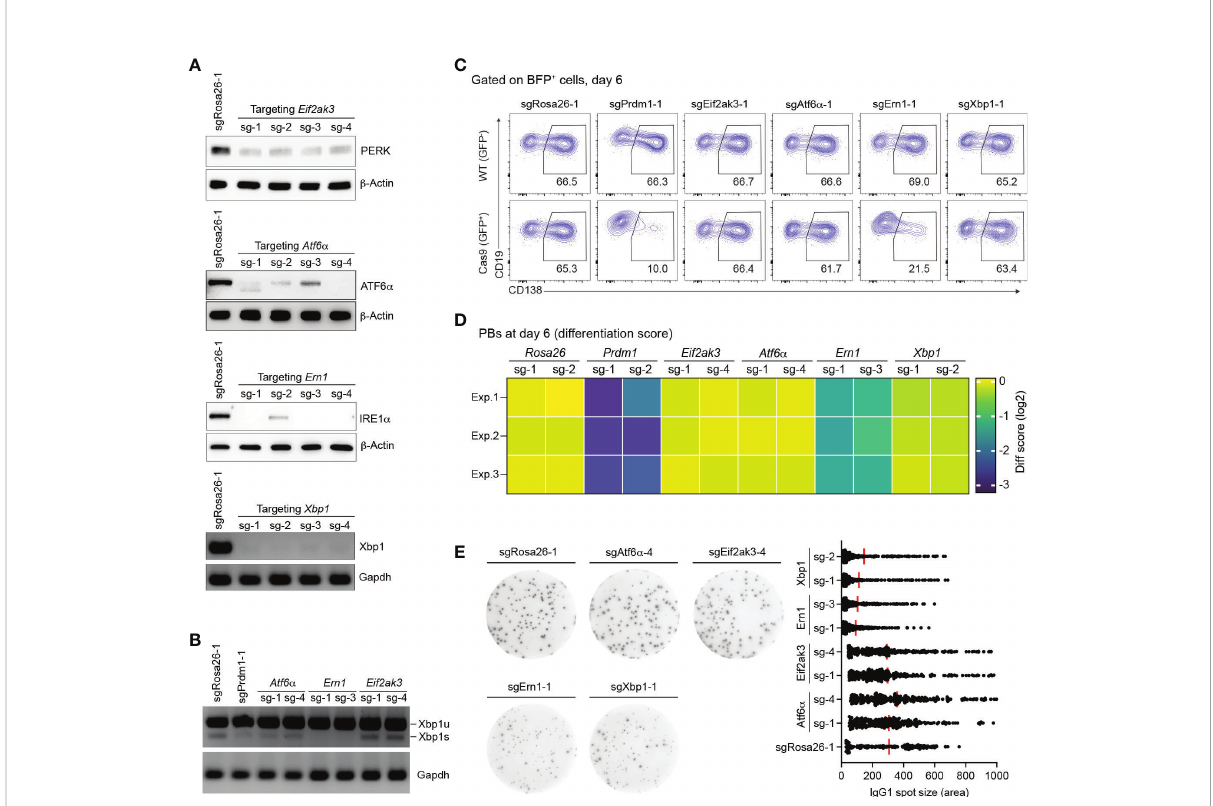
FIGURE 2 Loss of IRE1 a , but not XBP1, arrests PB differentiation. (A) Western blots or semiquantitative-PCR assays showing gene KO ef fi ciencies of sgRNAs targeting Eif2ak3 , Atf6 a , Ern1 and Xbp1 genes. SgRosa26-1 was used as a negative control. Beta-Actin or Grapdh was used as a loading control. (B) Xbp1u and Xbp1s mRNAs were measured by semiquantitative-PCR in cells treated with sgRNAs as indicated. (C) FACS analysis of PB differentiation, as measured by the expression of CD138. Gates are set on CD138 + PBs in WT (GFP - , top) and Cas9 (GFP + , bottom) cells. (D) Heatmap of differentiation score in cells treated with the indicated sgRNAs (n=3 independent experiments). (E) Representative ELISPOT images showing antibody secretion in cells treated with the indicated sgRNAs. Graph showing size (area) of IgG1 spots, quanti fi ed from a pool of 3 independent